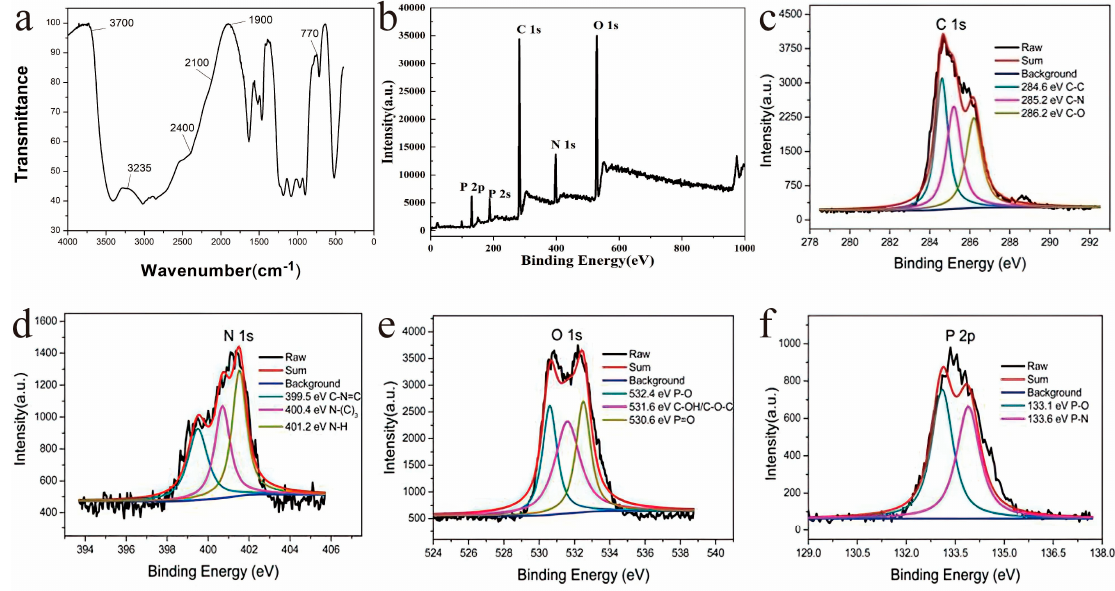
Figure 2. FTIR spectra ( a ), XPS full spectra ( b ), C 1s spectra ( c ), N 1s spectra ( d ), O 1s spectra ( e ), and P 2p spectra ( f ) of RTPL materials.